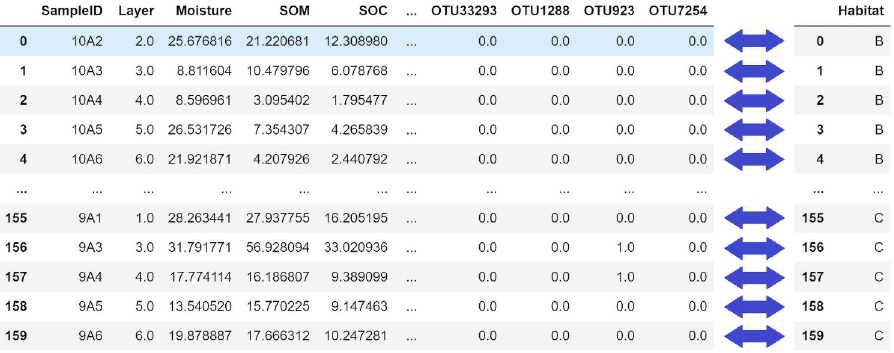
PLOS ONE | https://doi.org/10.1371/journal.pone.0256782 September 10,